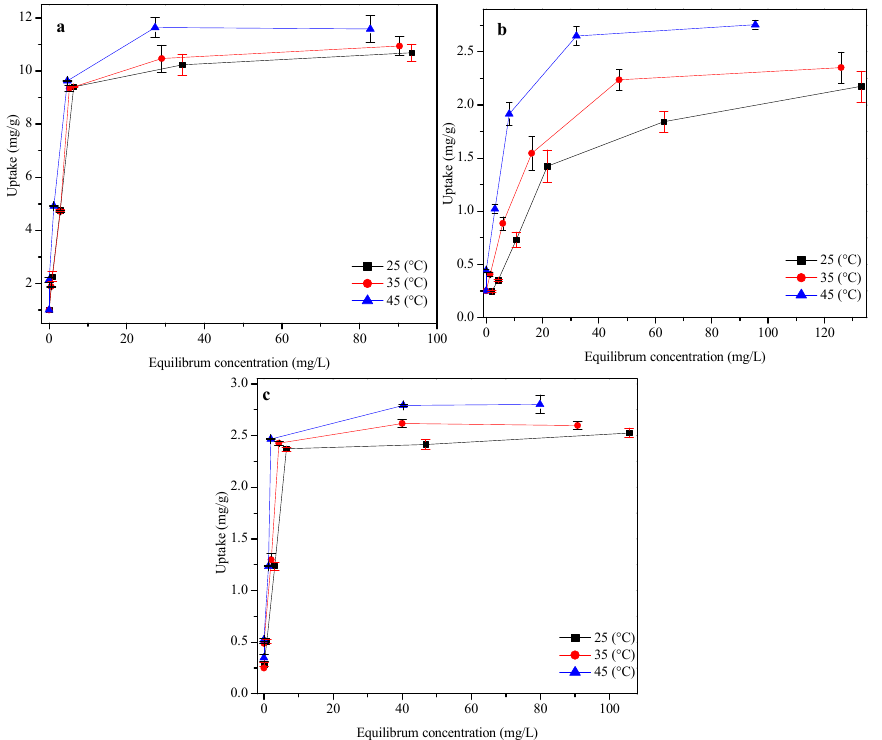
Figure 8. Effect of temperature on MCNC and equilibrium data fit to linear plots: ( a ) adsorption equilibrium isotherms of Cu; ( b ) adsorption equilibrium isotherms of Fe; ( c ) adsorption equilibrium isotherms of Pb sorption (initial concentration of (Cu/Pb/Fe): 10 to 200 mg/L, pH: 7.20, volume: 50 mL, coagulant dosage: 0.5 mg/L).